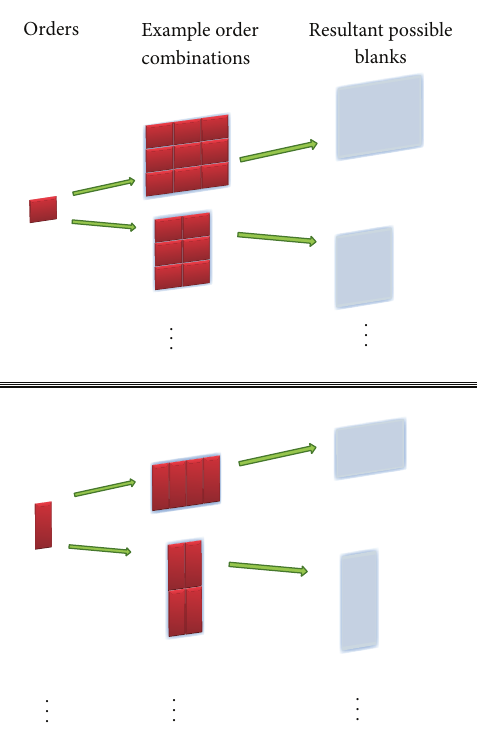
Figure 3: Using orders to create possible